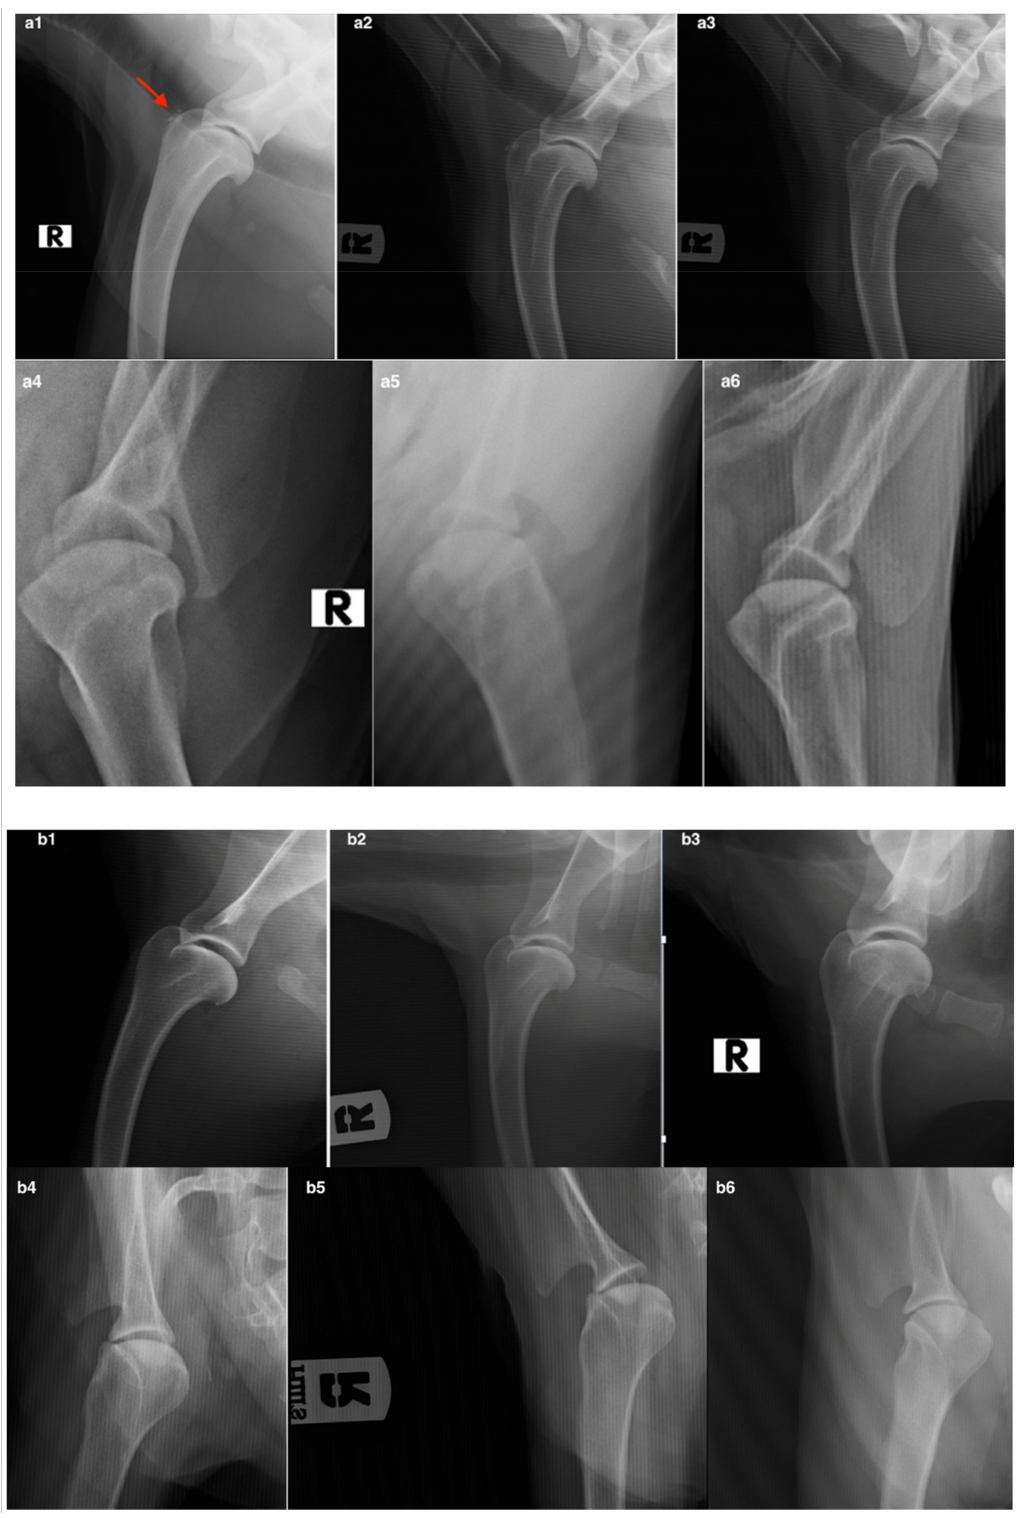
Figure 7. The figure shows the radiographic examination performed in the MFAT group at T0 ( a1 – a4 ), T1 ( a2 – a5 ), and T2 ( a3 – a6 ) and in the Hyaluronic group at T0 ( b1 – b4 ), T1 ( b2 – b5 ), and T2 ( b3 – b6 ). Figure ( a1 – a6 ): X-ray images of a patient of the MFAT group show a picture of chronic shoulder arthrosis with the presence of osteophytes (red arrow) ( a1 ). Figure ( b1 – b4 ) shows a radiographic picture of chronic shoulder osteoarthritis of a patient in the control group at T0. Figures ( b2 – b5 ) and ( b3 – b6 ) show the evolution of the radiographic picture at the assessment times T1 and T2 compared to